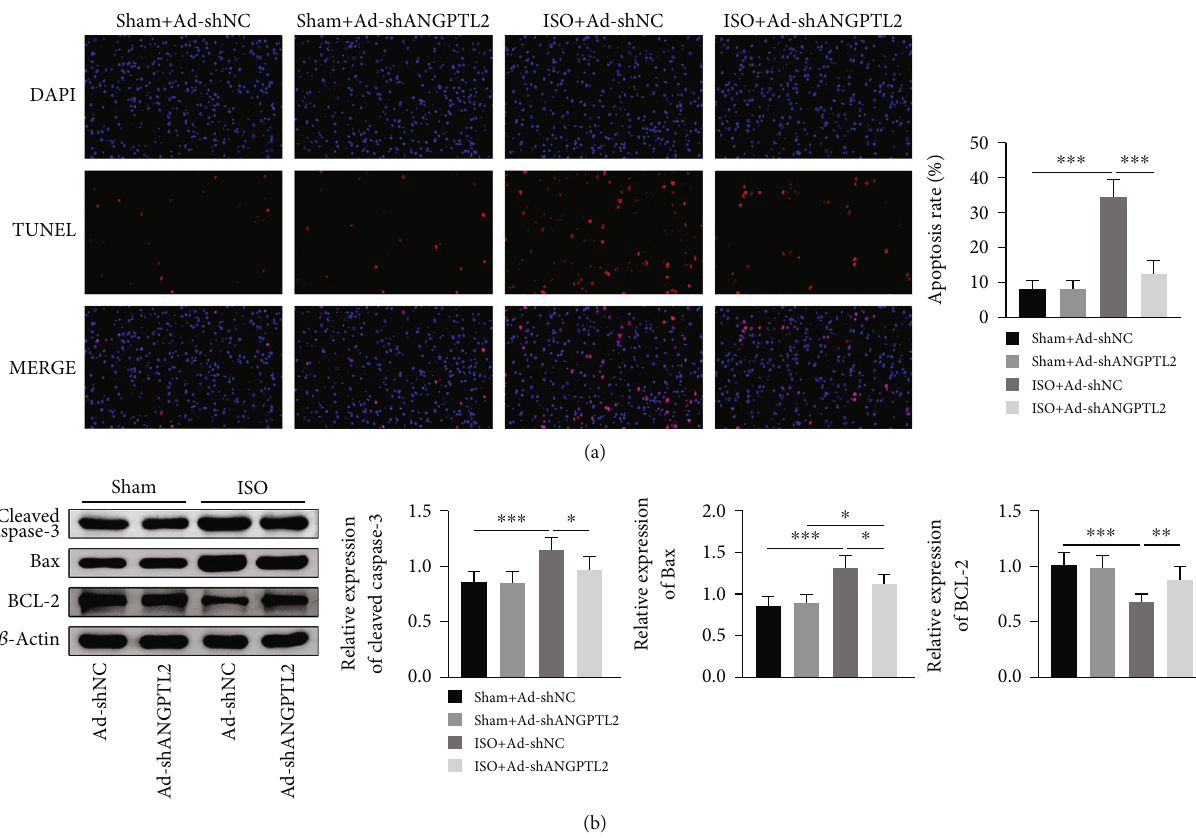
Figure 2: Downregulation of ANGPTL2 inhibited iso fl urane-induced cell apoptosis in mice. (a) TUNEL assay was used to detect cell apoptosis of brain tissues. (b) The expression of cleaved caspase-3, Bax, BCL-2, and β -actin protein levels was examined via western blotting. n = 6 . ∗ p < 0 : 05 , ∗∗ p < 0 : 01 , and ∗∗∗ p < 0 : 001